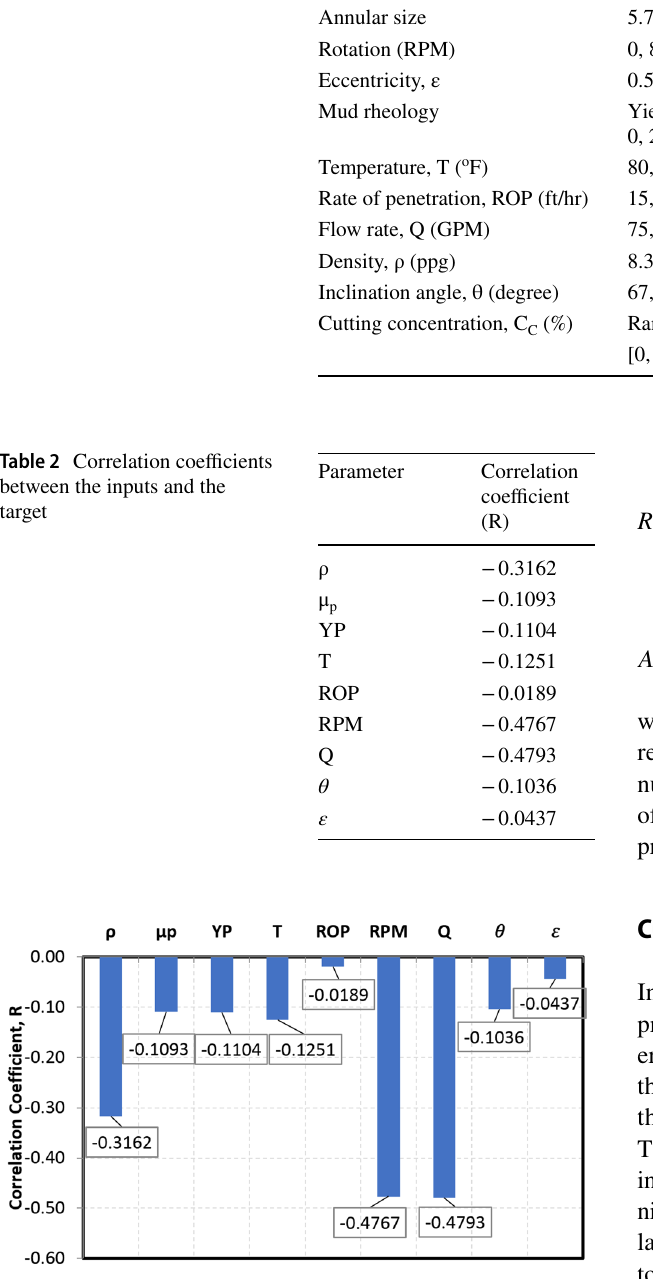
Table 1 Test matrix (Yu et al. 2007)